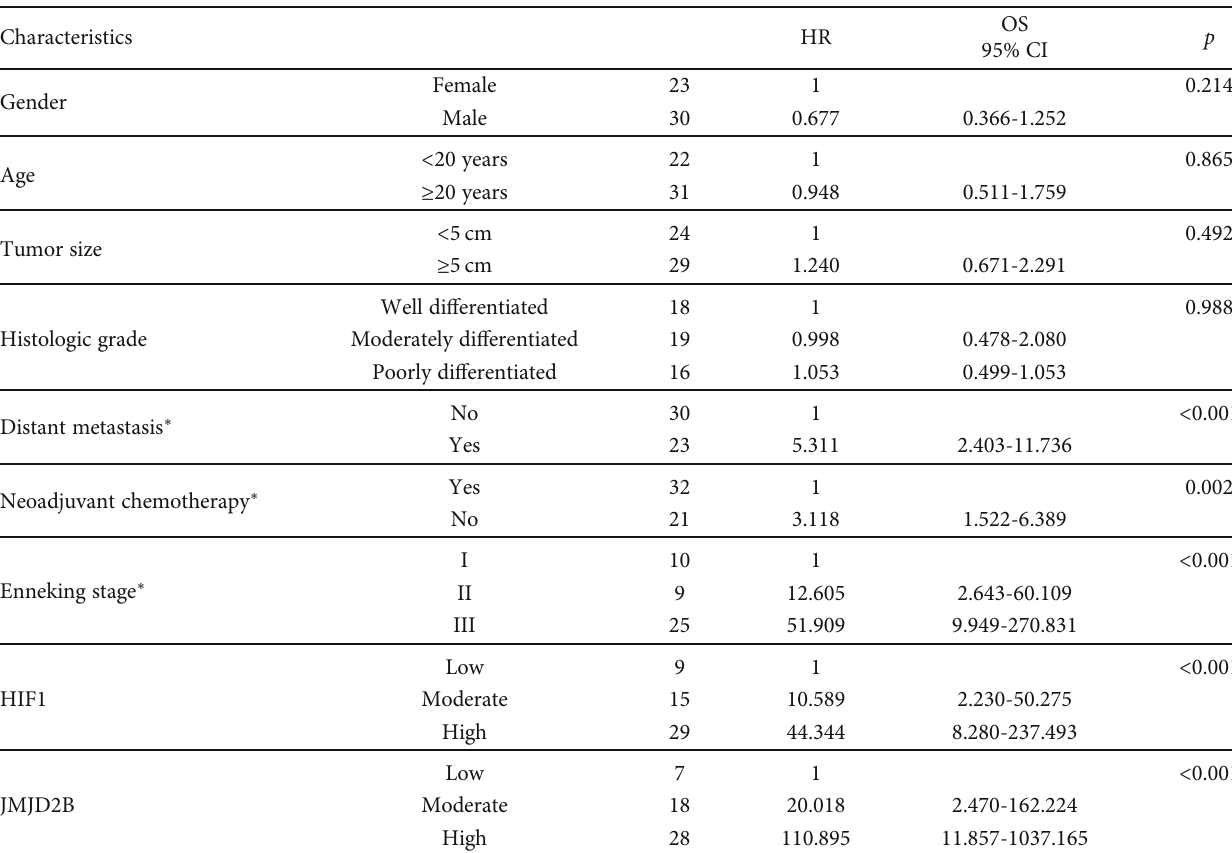
Table 3: Univariate Cox proportional regression analysis for the association of clinicopathological factors with overall survival of OS patients.